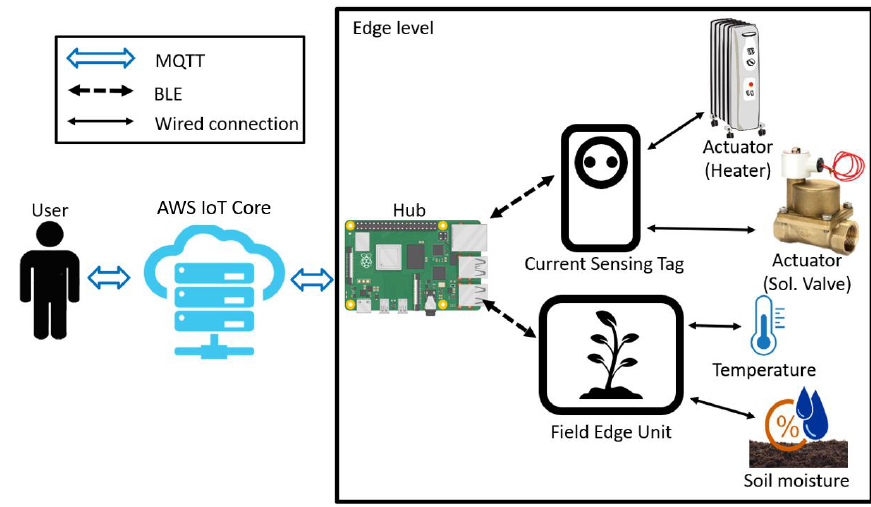
Figure 4. Closed-loop system at the cloud level vs. edge level.